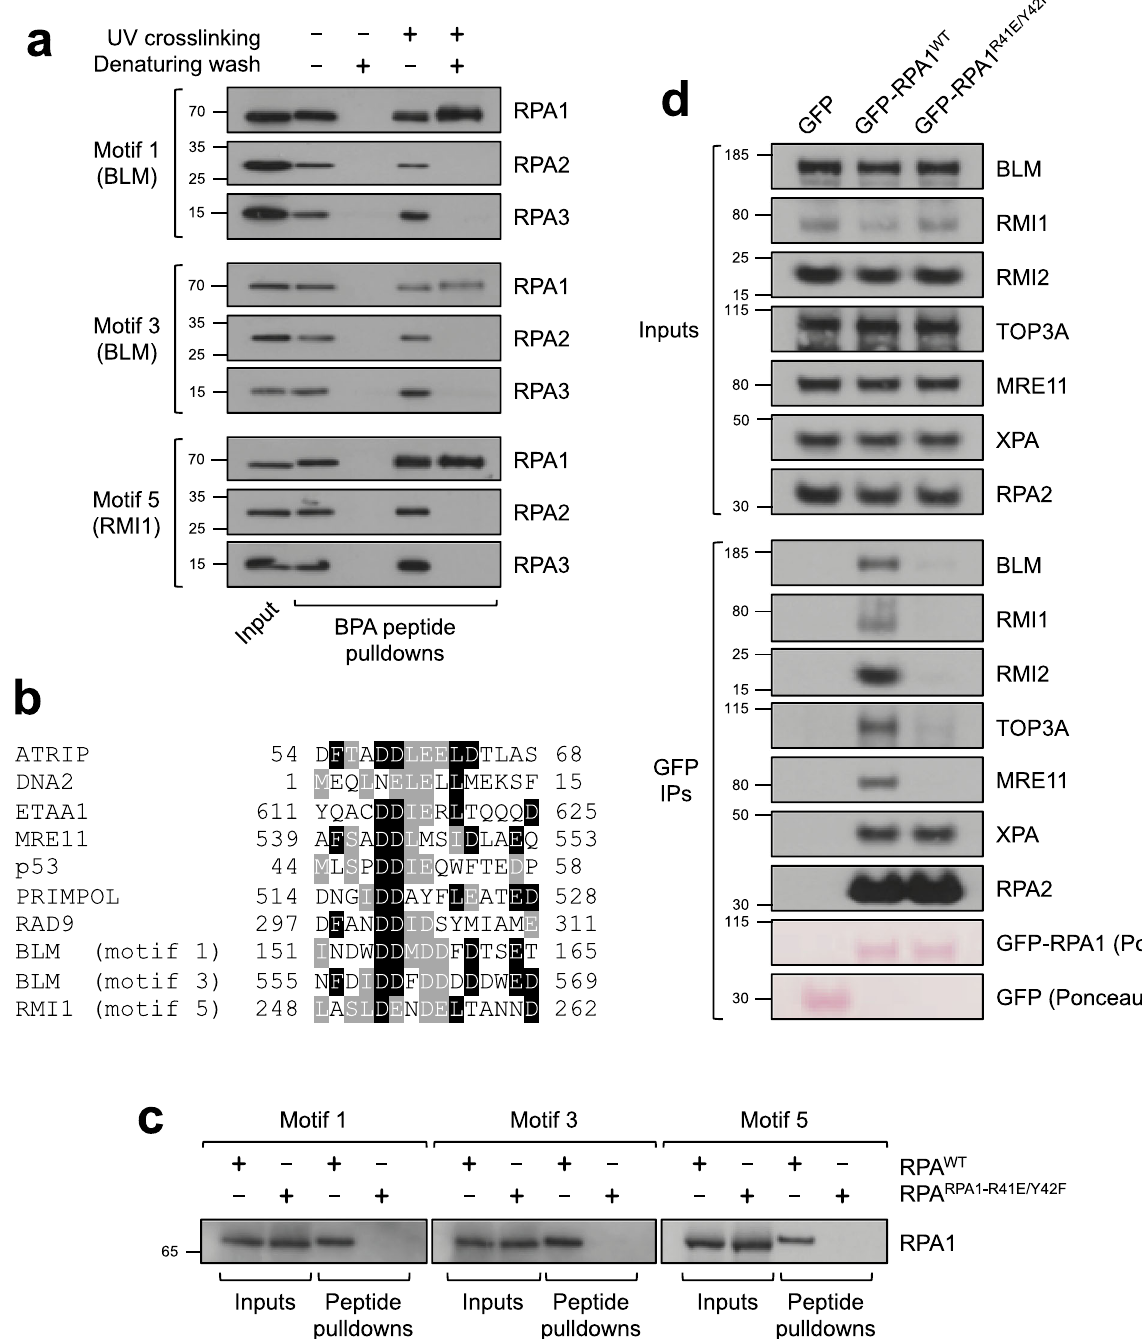
Fig. 2 The RPA-binding motifs in BLM and RMI1 interact with the RPA1 N-terminal OB-fold. a BPA-modi fi ed peptide pulldowns from HeLa nuclear extracts with UV-crosslinking and denaturing washes where indicated, demonstrating that motifs 1, 3, and 5 interact directly with the RPA1 subunit of RPA. b Sequence alignments showing the similarity of RPA1-binding motifs in DNA damage response proteins. c Peptide pulldowns from rabbit reticulocyte lysates containing in vitro translated heterotrimeric RPA complexes incorporating either WT or R41E/Y42F RPA1, showing that all three BLM/RMI1 motifs cannot interact with the mutant RPA complex. d GFP-pulldowns from 293FT cells transfected with constructs expressing GFP or the indicated GFP-tagged RPA1 variants, showing that mutation of the N-terminal OB-fold of RPA1 (R41E/Y42F) disrupts binding to the BTR complex and MRE11. XPA is a negative control because it binds to RPA via different